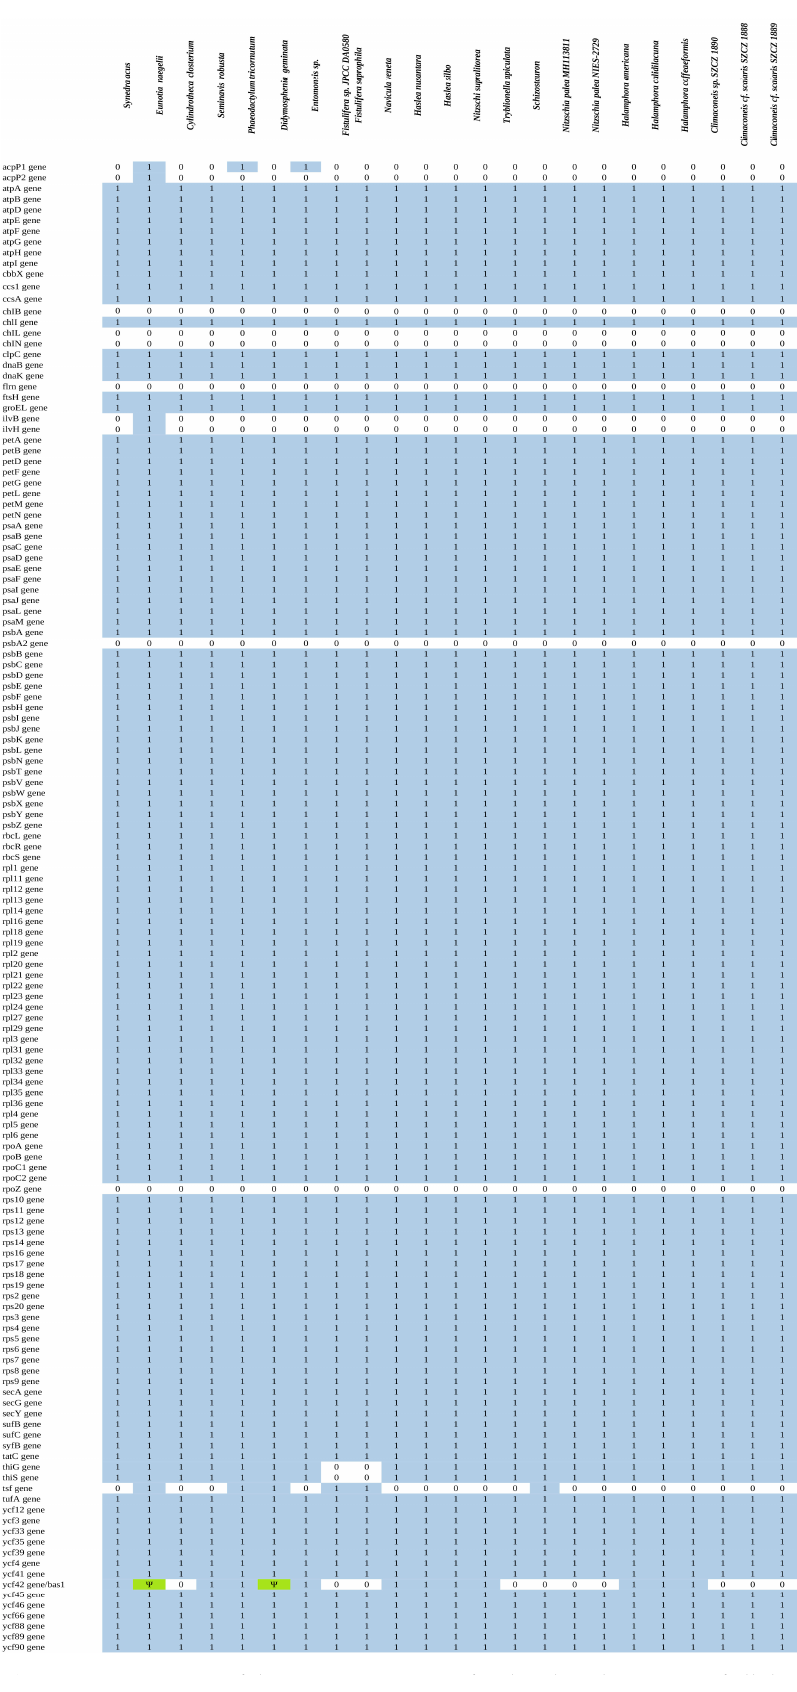
Figure 6. Comparison of the gene composition for the plastid genomes of all the species used in the phylogeny below. A 1/blue indicates the presence of the gene, a 0/white its lack, and a Ψ /green a pseudogene version of the gene.